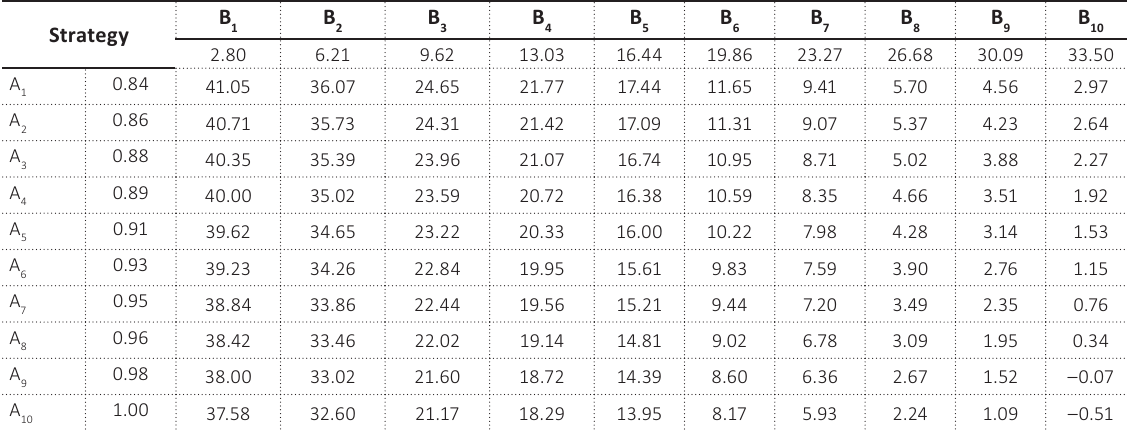
Table 8. Matrix for determining the optimal value of the unemployment rate, which ensures the achievement of the targeted level of a country’s macro-financial stability and the minimization of the size of the shadow